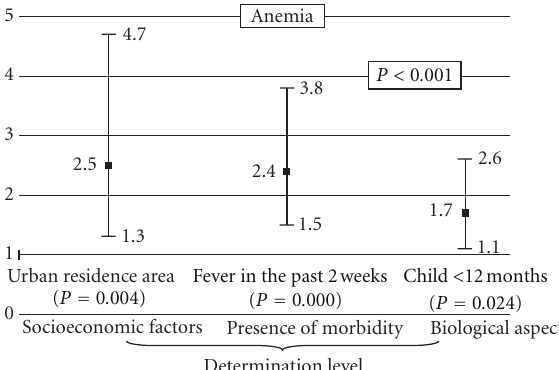
Figure 1: Multiple logistic regression of risk factors for mild anemia (Hb < 11.0 g/dL) of children younger than 24 months old who par- ticipated in the Brazilian National Survey on Demography and the Health of Women and Children (PNDS 2006), with odds ratios and their respective confidence intervals (95% CI). ∗ Control variables: geopolitical macroregion, per capita family income, retinol serum level, and